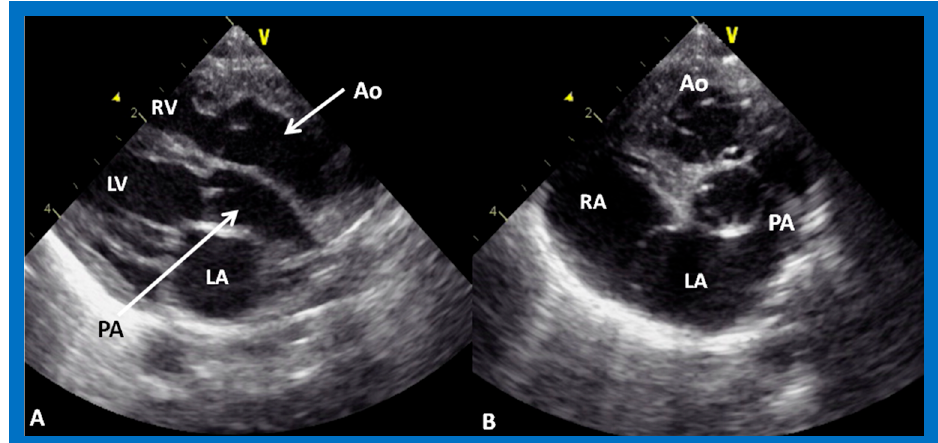
Figure 47. Echo images in parasternal long ( A ) and short ( B ) axis projections of a baby with transposition of the great vessels illustrating anterior ( A , B ) and right-ward ( B ) position of the aortic valve and aorta (Ao) relative to the position of the pulmonary valve and pulmonary artery (PA). These images also demonstrate that the PA and Ao are in parallel position ( A ). Left atrium (LA), left ventricle (LV), right atrium (RA), and right ventricle (RV) are labeled. Replicated from reference [42].